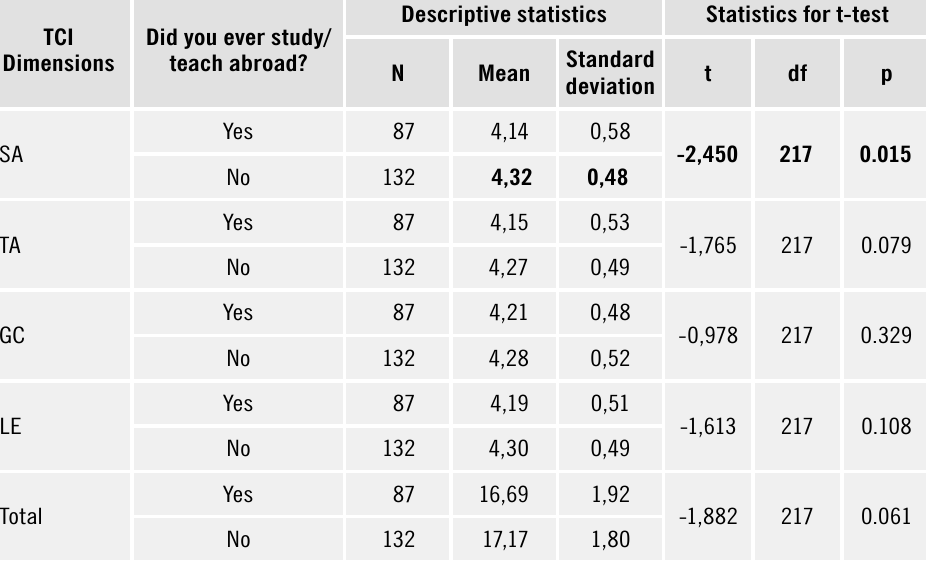
Table 3. Descriptive statistics and the t-test between respondents answering “Yes” or “No” to the question “Did you ever study/teach abroad?” for the group from